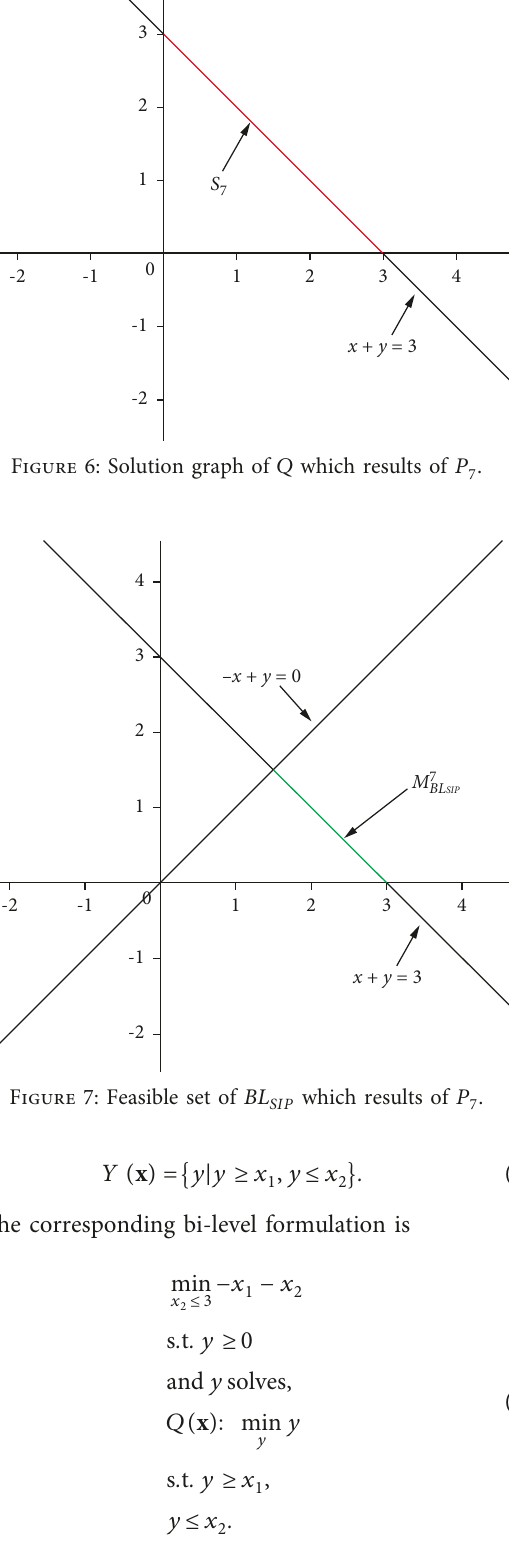
SIP which results of